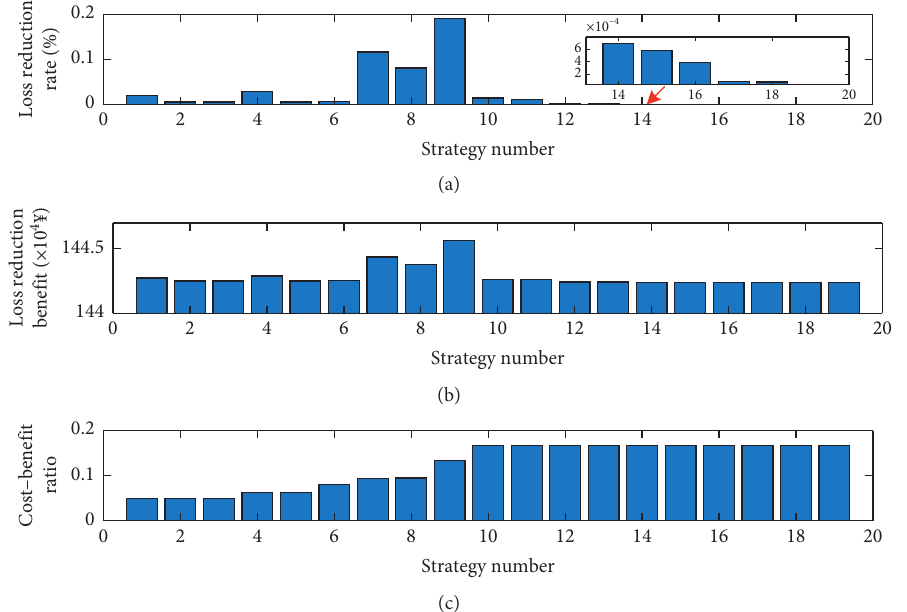
Figure 10: The cost-benefit calculation result of the individual optimal loss reduction strategy based on the cost-benefit ratio ranking.